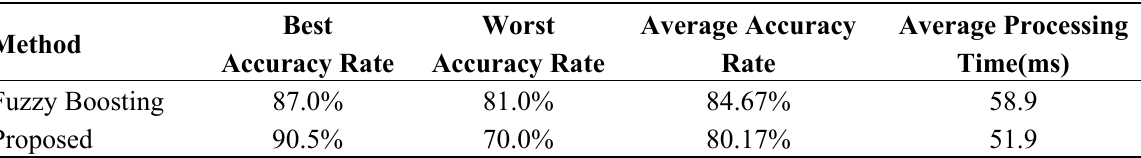
Table 8. The comparison with other methods in video